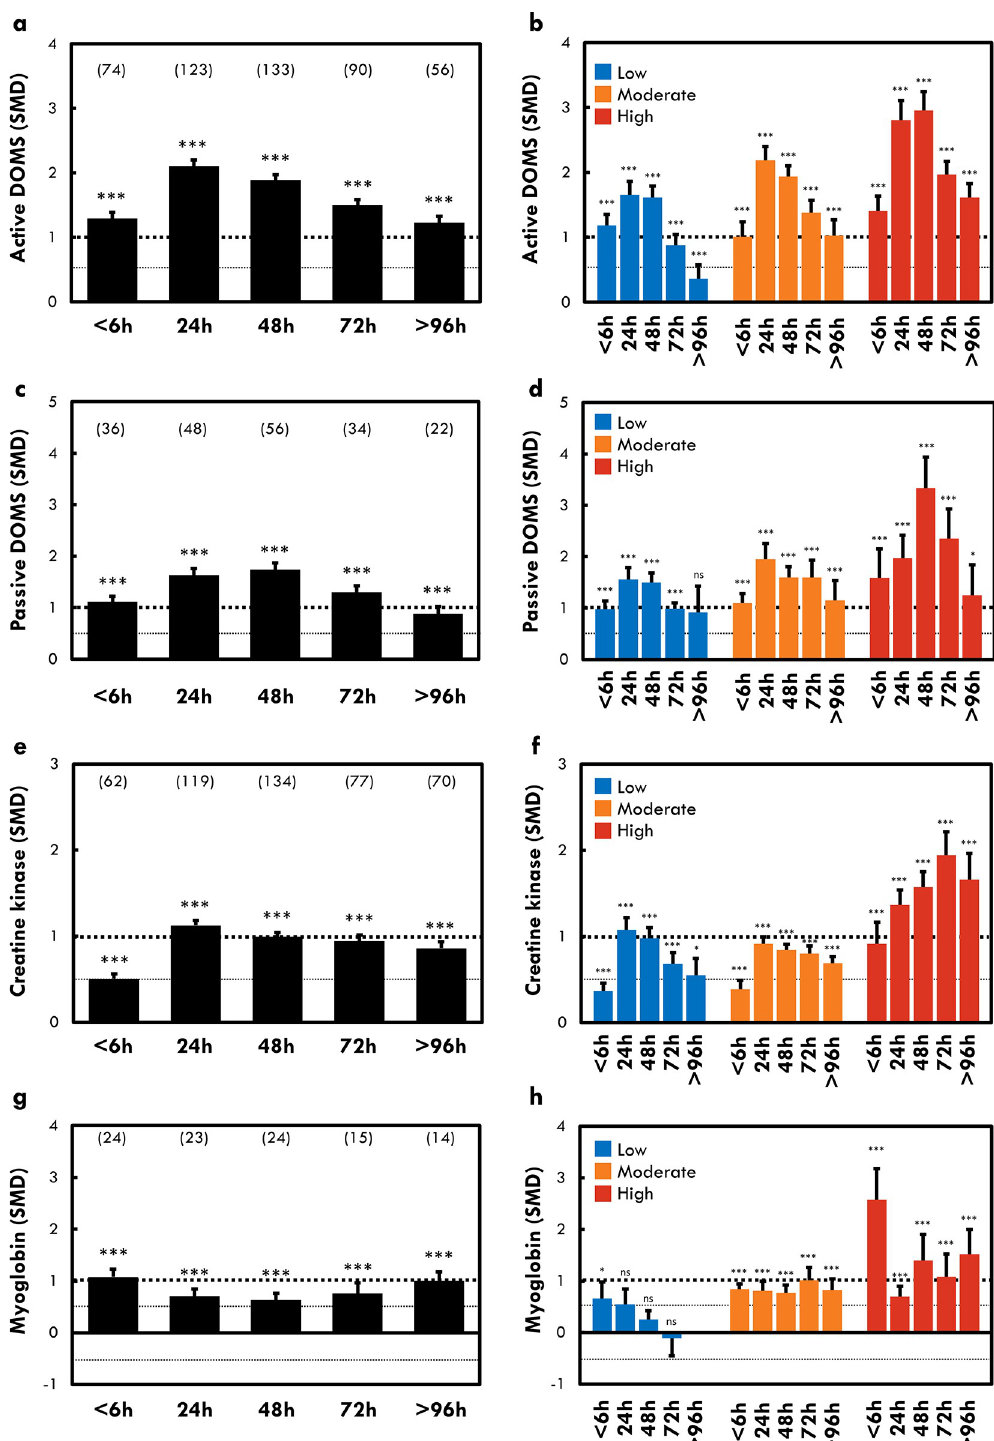
Fig 5. Time-course changes in active DOMS (a-b), passive DOMS (c-d), creatine kinase (e-f), and myoglobin (g-h). Standard mean difference (SMD) and standard error were displayed for all included groups (a, c, e, g) and for three clusters representing three levels of maximal voluntary contraction torque loss (b, d, f, h). The number in parenthesis represents the number of studies included in the analysis. Significant differences from baseline (before the damaging exercise) were displayed: � : p < 0.05; �� : p < 0.01; ��� ; p < 0.001; ns: